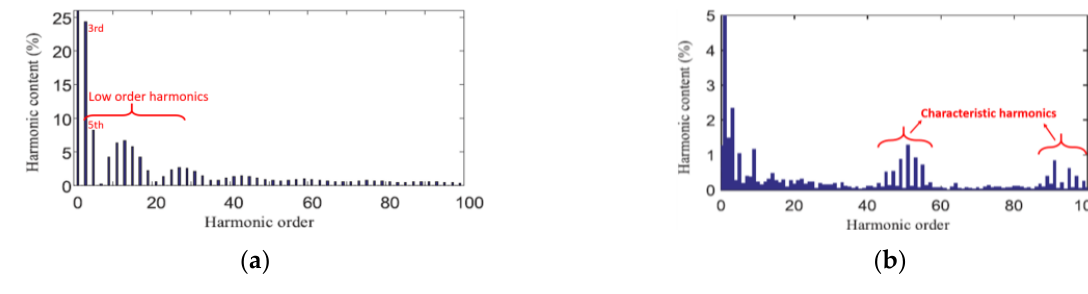
Figure 2. The harmonic spectrum of the traditional and modern trains. ( a ) Traditional SS4 locomotives. ( b ) High-speed modern CRH2 locomotives [24].